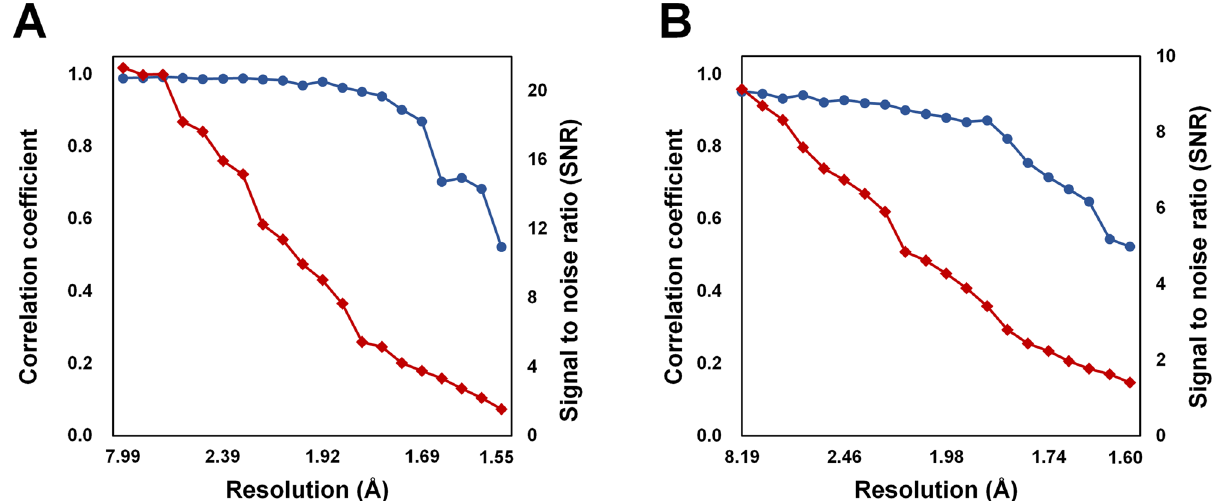
Figure 2. Quality of dataset for ( A ) lysozyme (indexed patterns: 23,090) and ( B ) glucose isomerase (indexed patterns: 7976) delivered in beef tallow. CC (blue circle) and signal-to-noise ratio (red diamond) were plotted as a function of resolution.